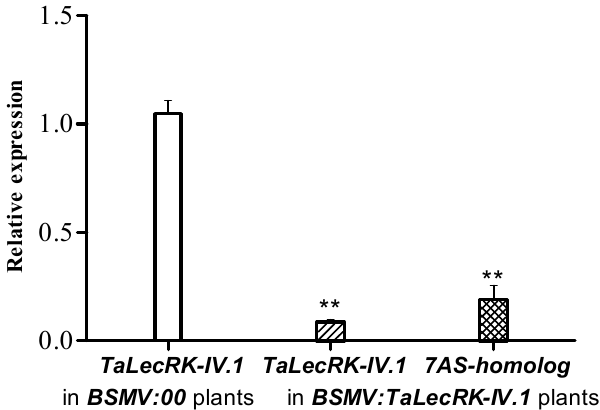
Figure 2. Analysis of TaLecRK-IV.1 expression in CI12633 after the gene-silencing experiment. BSMV:00 plants were infected with the empty BSMV vector and used as control, whereas BSMV: TaLecRK-IV.1 plants were inoculated with BSMV vector carrying a fragment of TaLecRK-IV.1 for gene silencing. The relative gene expression (comparative 2 −∆∆ C ) method was employed. The endogenous reference gene TaActin was used to normalize the expression level of TaLecRK-IV.1 . Double asterisks indicate significant expression difference at 0.01 probability level as compared to the relative expression in control by using the Student’s t -test.